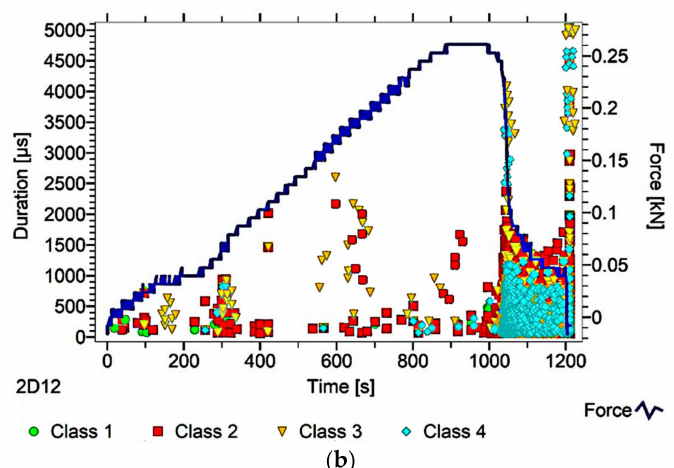
Figure 4. AE signal graphs for the mock BW sample: ( a ) signal strength distribution in time; ( b ) signal duration distribution in time, with plotted force increment curve.